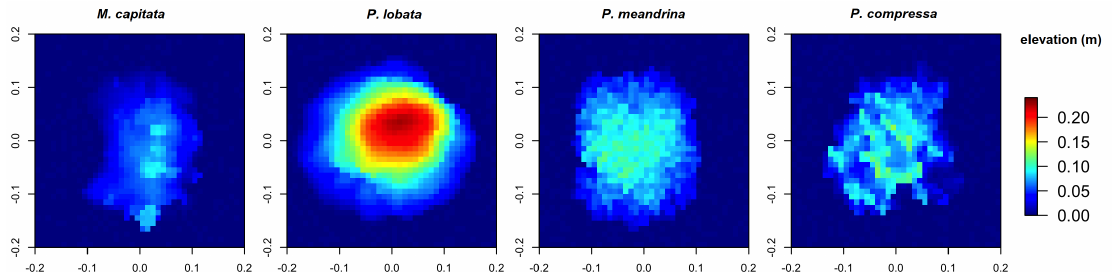
Figure 6. Digital Elevation Models obtained from the four reconstructed coral colonies with different morphologies with a substratum: encrusting M. capitata , mounding P. lobata , branching P. meandrina and branching P. compressa